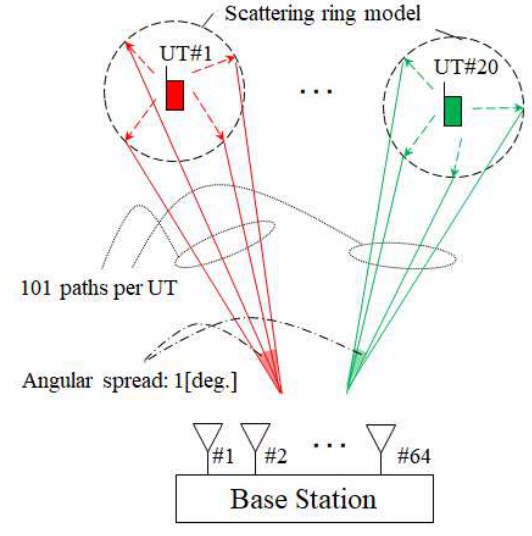
Figure 4. Simulation